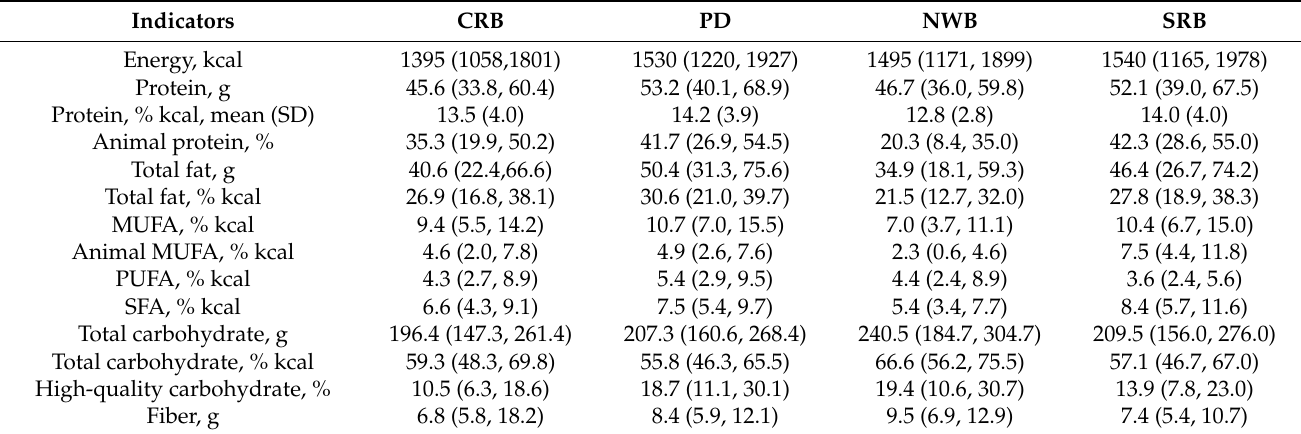
Table 1. Nutrient intakes of study population with different dietary patterns, 2015 *.